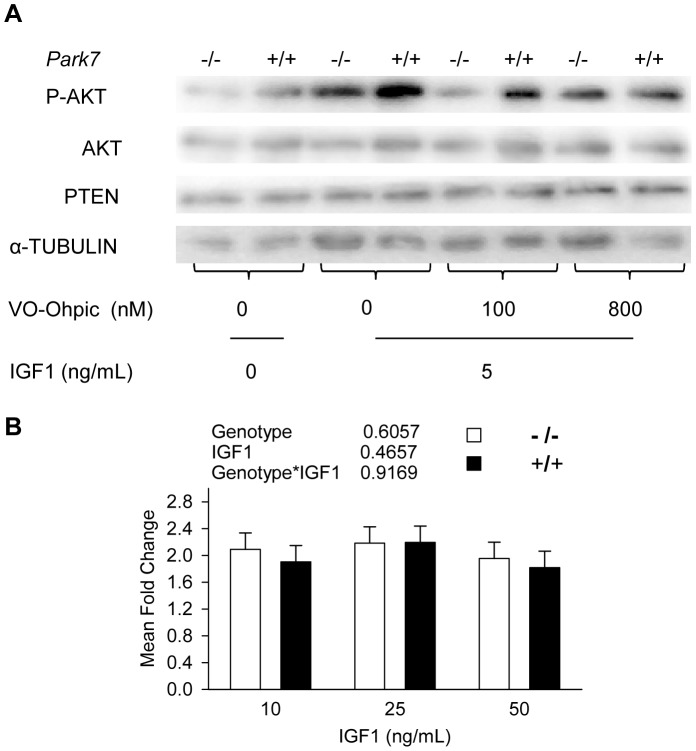
PARK7 Inhibits PTEN function, but not PTEN expression.A: Western blot analysis of phosphorylated AKT (S473) in Park7 (+/+) and Park7 (−/−) myotubes in the presence of different concentrations of PTEN inhibitor (VO-OHpic) after IGF1 stimulation. Differential phosphorylation of AKT due to Park7 genotype was eliminated by the PTEN inhibitor VO-Ohpic at 800 nM. No differences were detected in PTEN expression. α-Tubulin was the control for protein loading B: Detection of Pten mRNA level in myotubes by quantitative PCR. No significant differences were detected between the two genotypes or IGF1 treatment. The mean fold change was calculated using the 2 –ΔΔCt method with Rplp38 as the housekeeping gene and no added IGF1 as the control treatment.